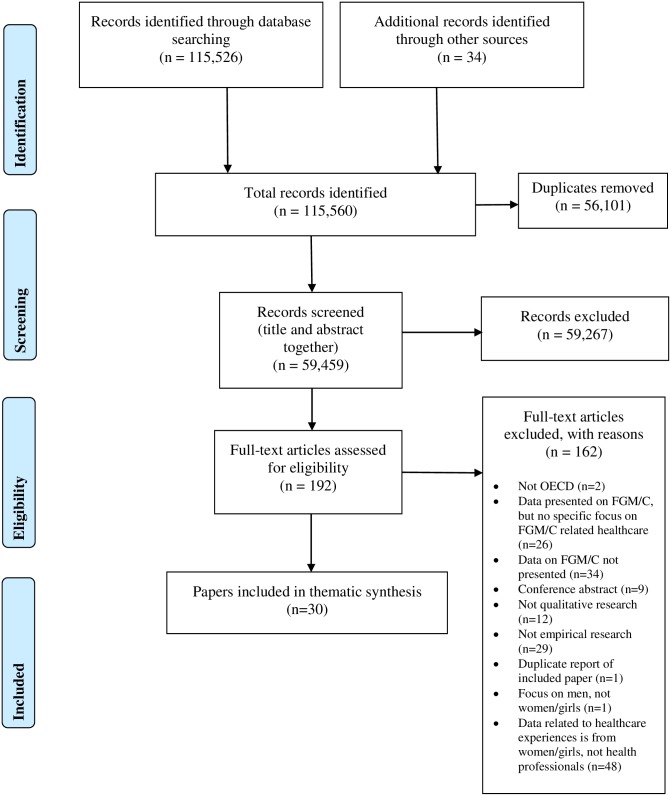
PRISMA flow diagram.